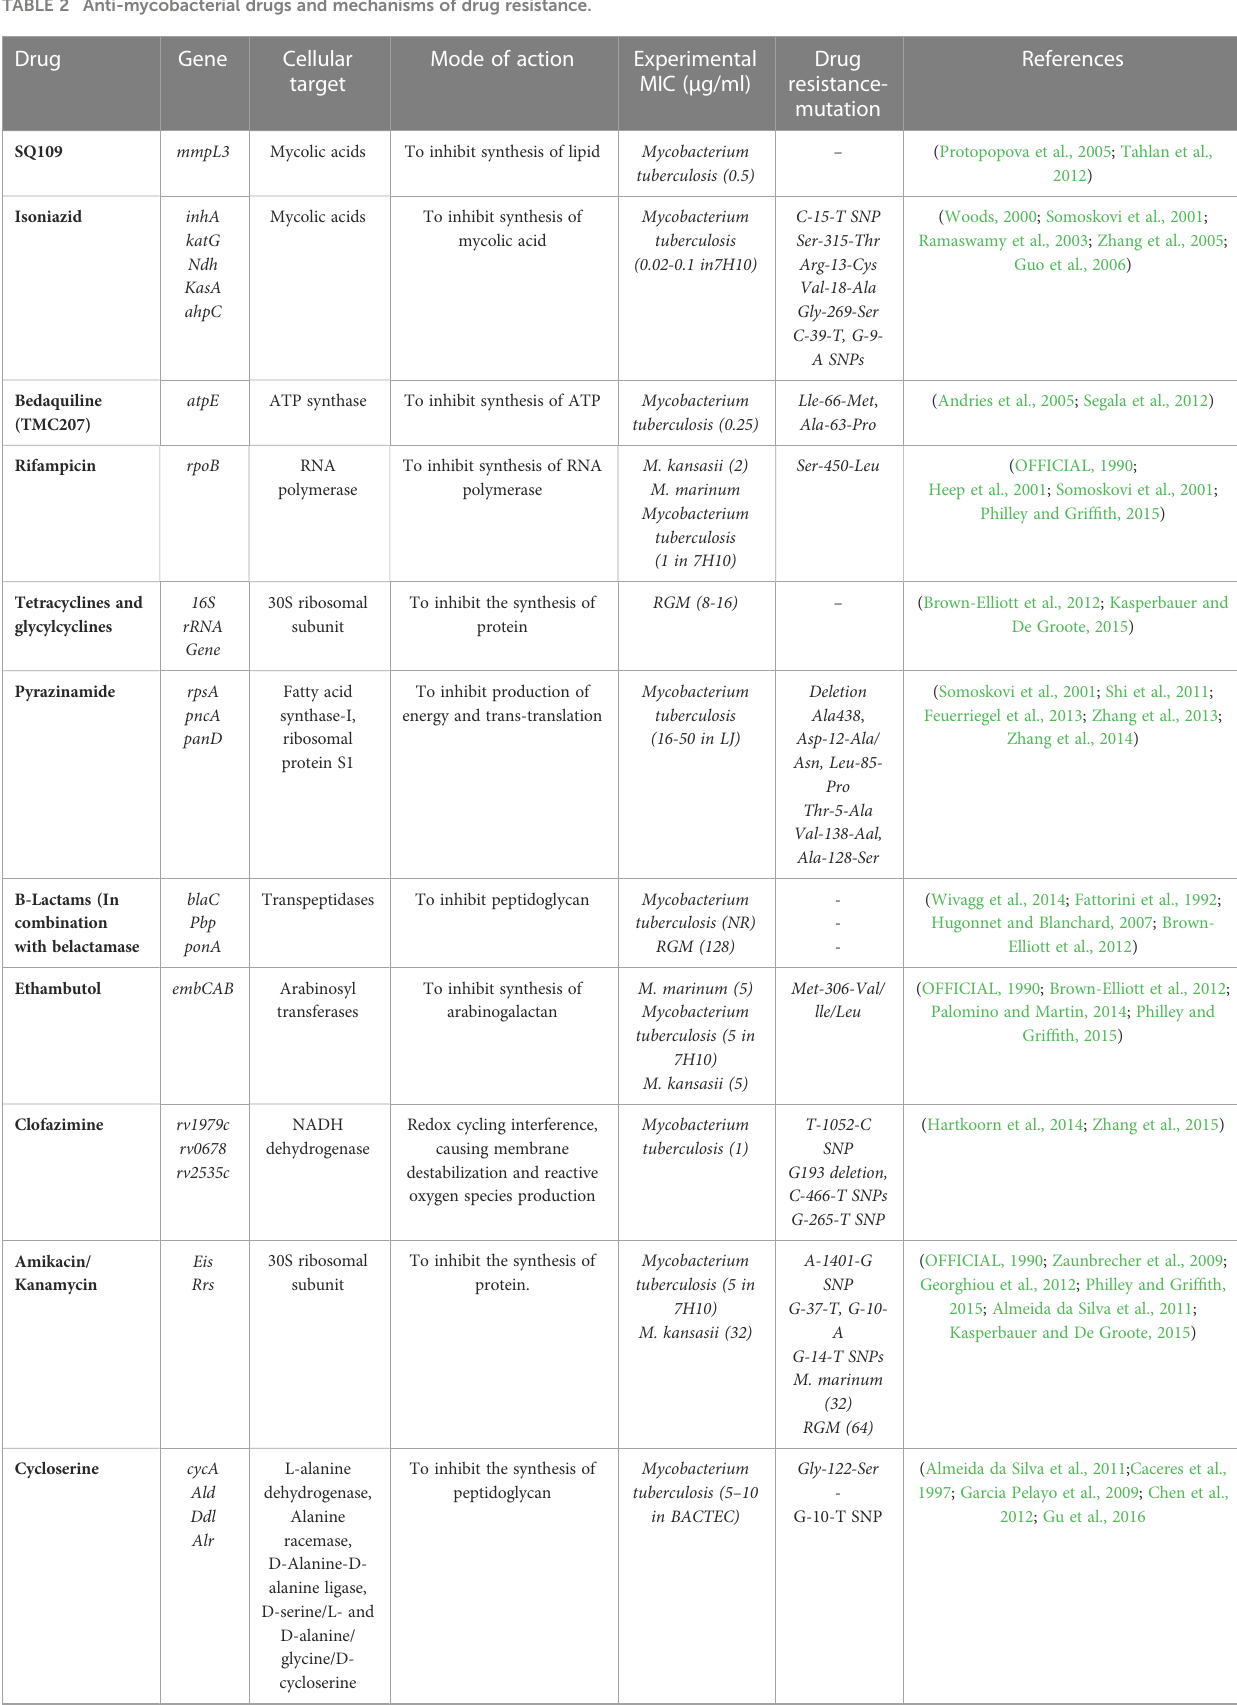
TABLE 2 Anti-mycobacterial drugs and mechanisms of drug